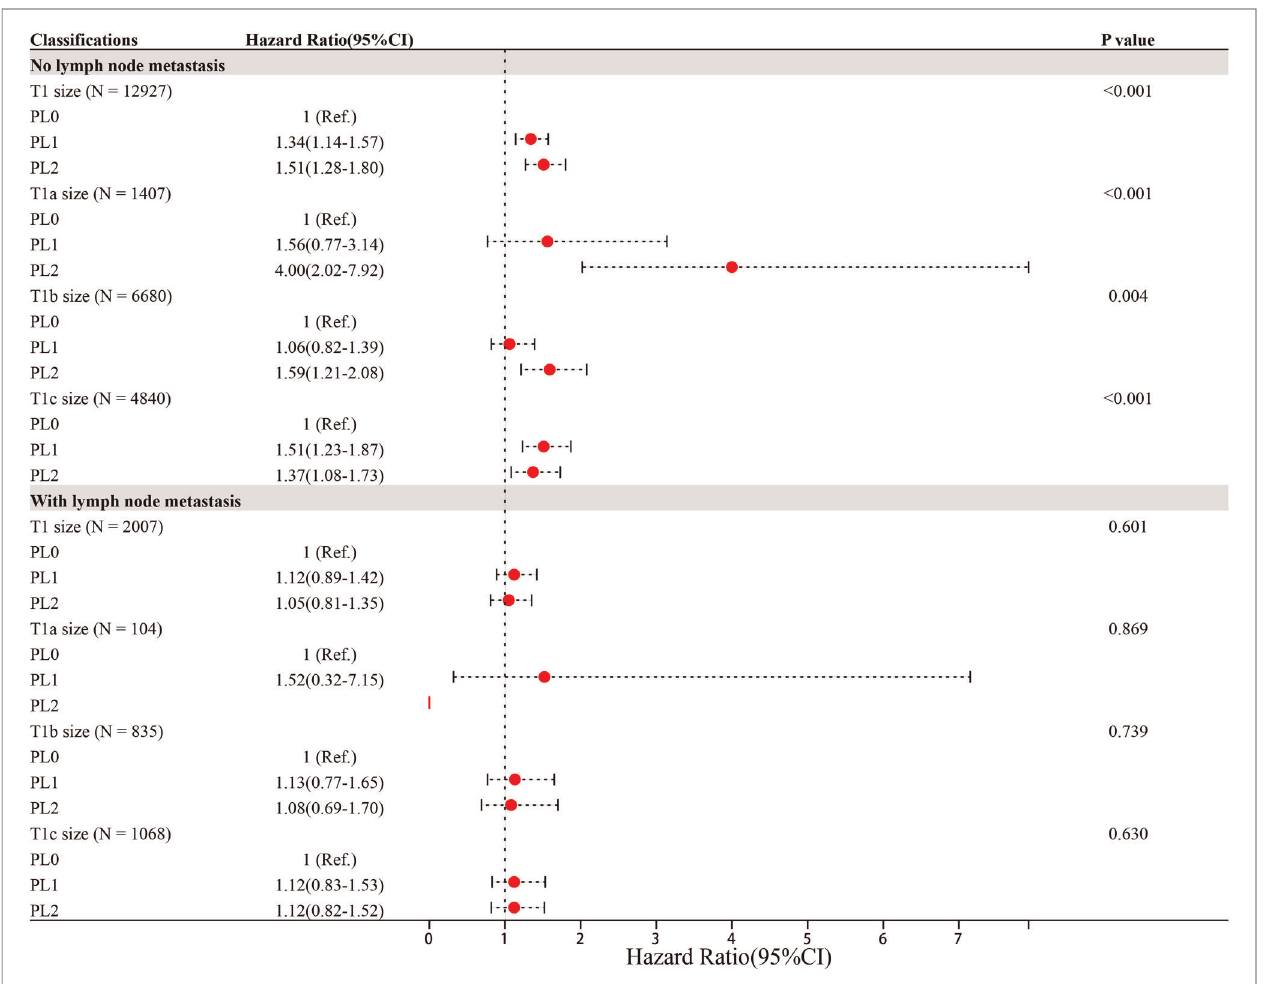
FIGURE 3 | Hazard Ratio (95%CI) of PL1 and PL2 in each subgroup Note: Age, sex, race, location, grade, histology, surgery type, radiation, chemotherapy and marriage were